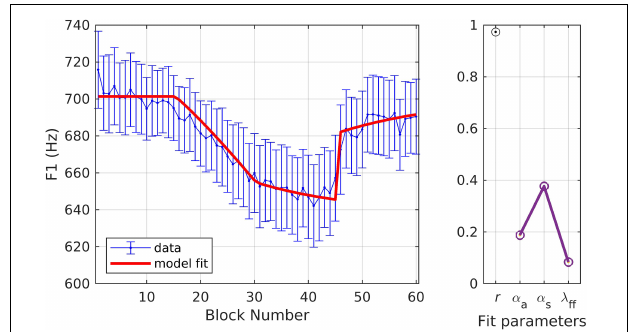
FIGURE 11 | Simulation 9: model fits of a dataset with perturbations applied to F1 and with a sudden ramp phase. Model parameters were fixed using the parameters in simulation 9 (data from Chao and Daliri, unpublished data). (Left) Mean and standard error of experimental data in blue; model fit in red. (Right) Fit quality ( r = correlation coefficient).